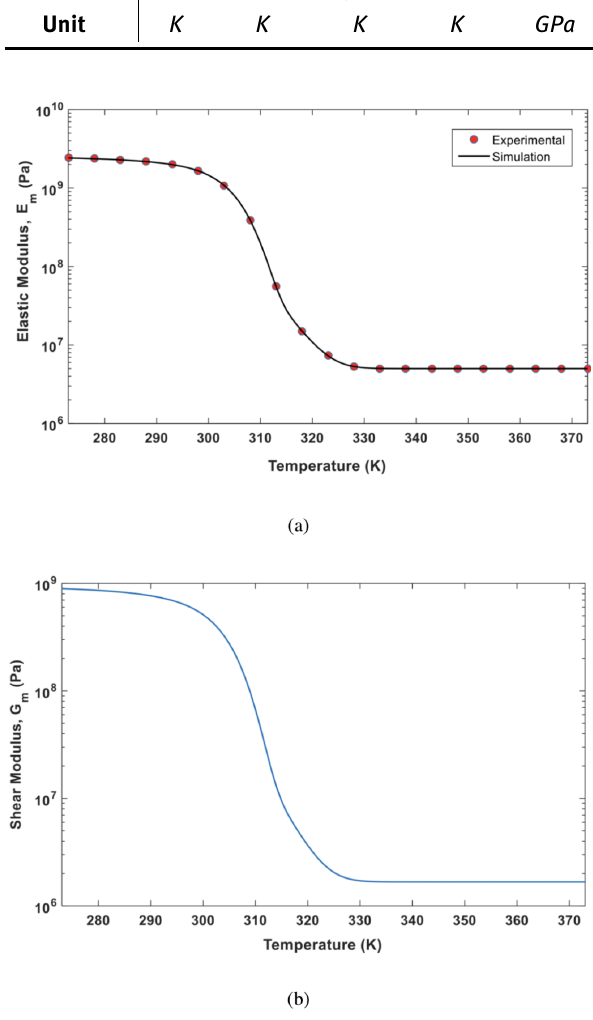
Figure 6: Modulus of SMP in glass transition region: (a) elastic modulus; (b) shear